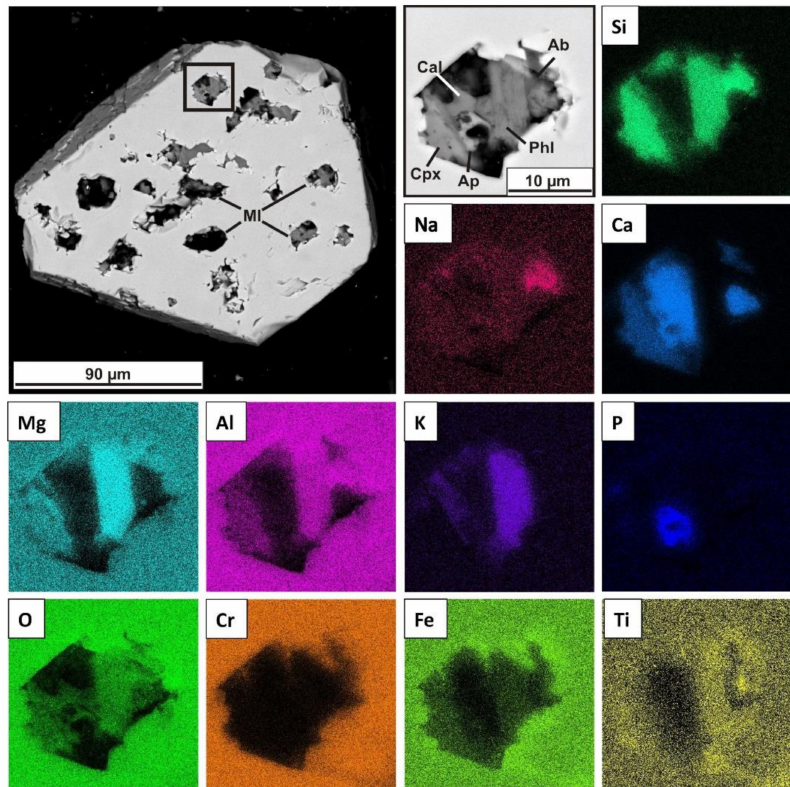
Figure 10. Melt inclusions (MI) in the Cr-spinel of the damtjernites of the Chuktukon complex, BSE images and electron microprobe (EMP) X-ray element maps. Ab—albite, Ap—apatite, Cal— calcite, Cpx—clinopyroxene,